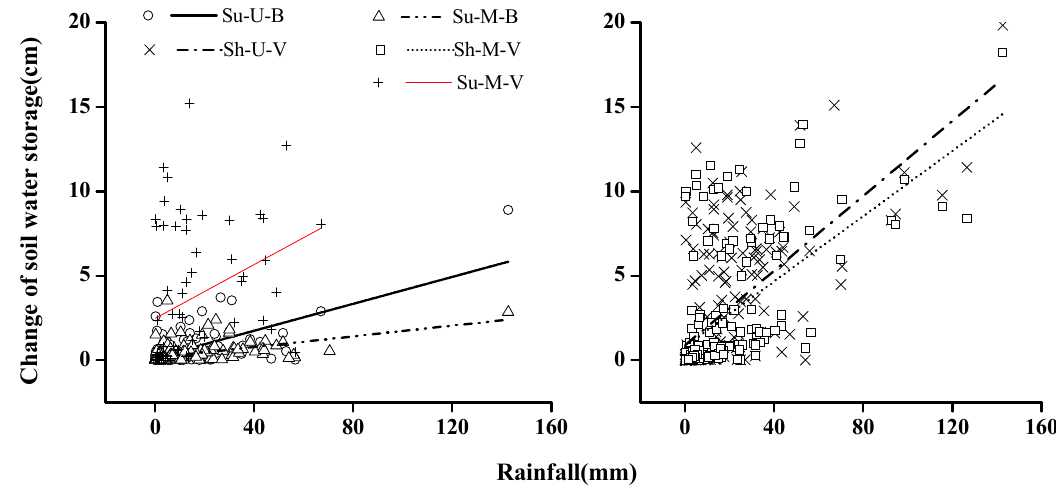
Figure 5. Change of soil water storage ( Δ SWS) in the five experimental sites after rainfall events.